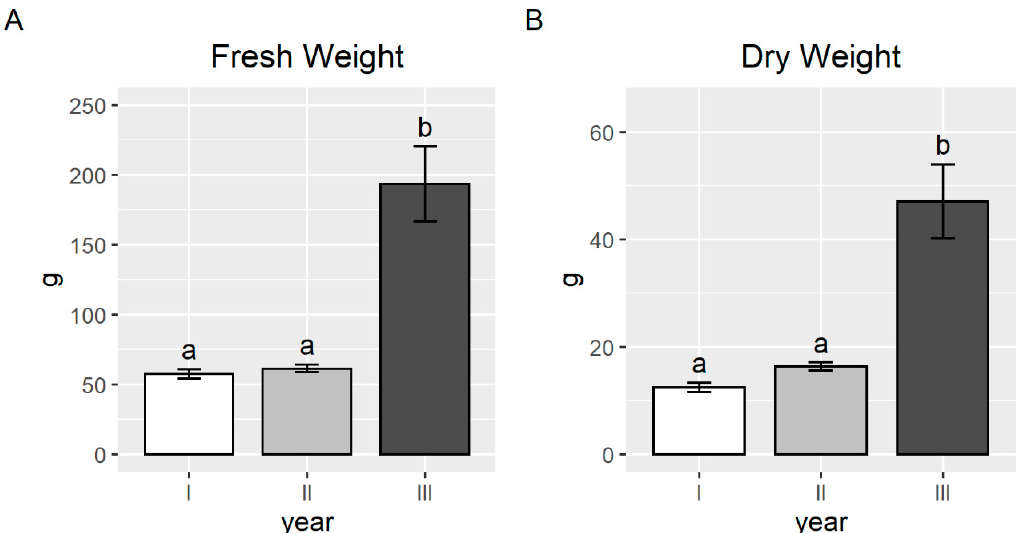
Figure 6. Average fresh weight ( A ) and dry weight ( B ) of P. vittata aerial parts in the pot experiment. Error bars indicate standard error and different letters indicates that the differences among the years were significant ( p -value < 0.05).